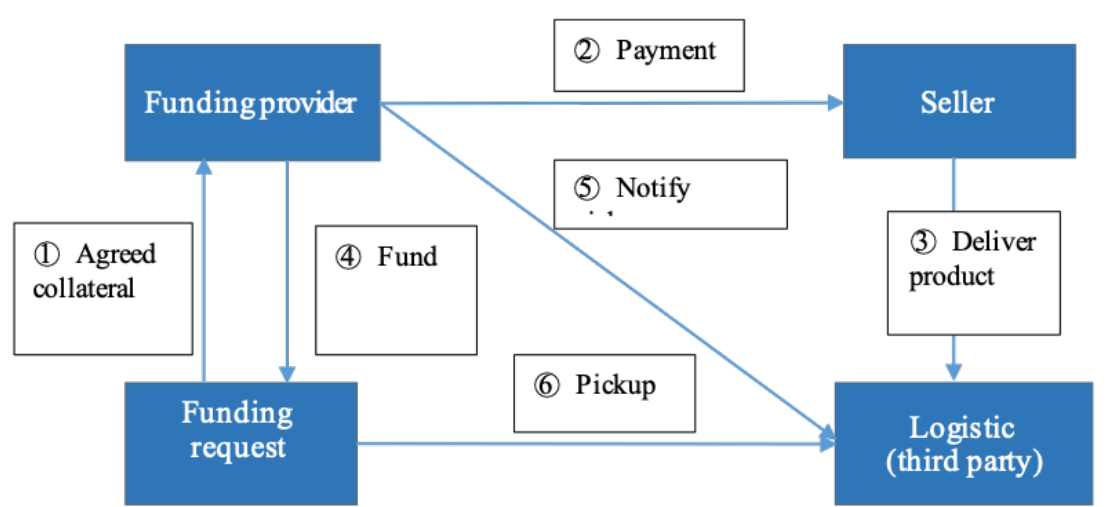
Figure 4. Advanced-based finance.